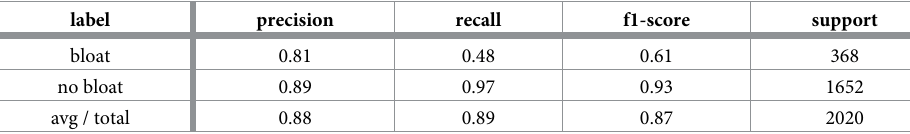
Table 4. Bloat classification report for test set.